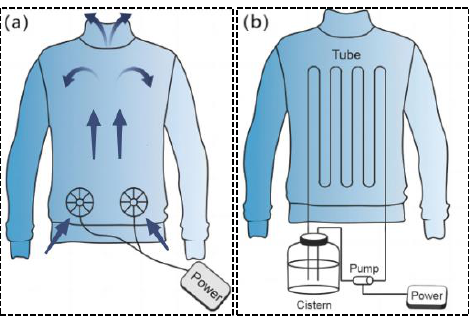
Figure 1. Schematic diagram of gas and liquid heat transfer. ( a ) Air cooling suit; ( b ) liquid cooling